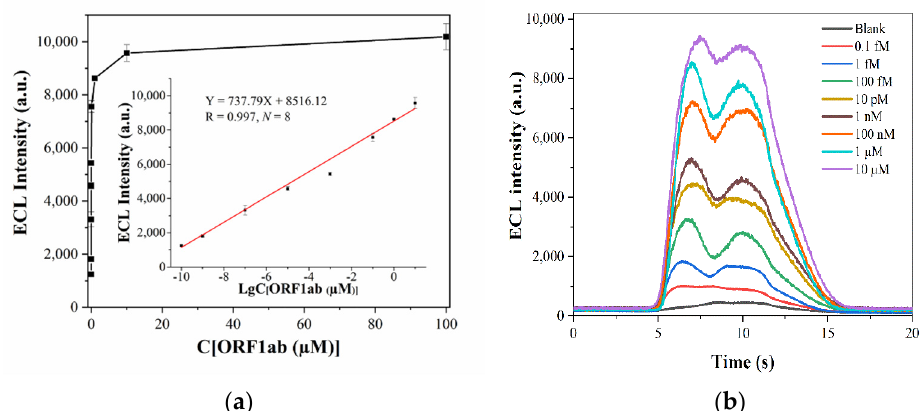
Figure 4. ( a ) Standard curve of detecting different concentrations of the nucleic acid of SARS-CoV- 2 using an ECL biosensor based on dual-probe hybridization. ( b ) The response curve of detecting different concentrations of the nucleic acid of SARS-CoV-2 using an ECL biosensor based on dual- probe hybridization.